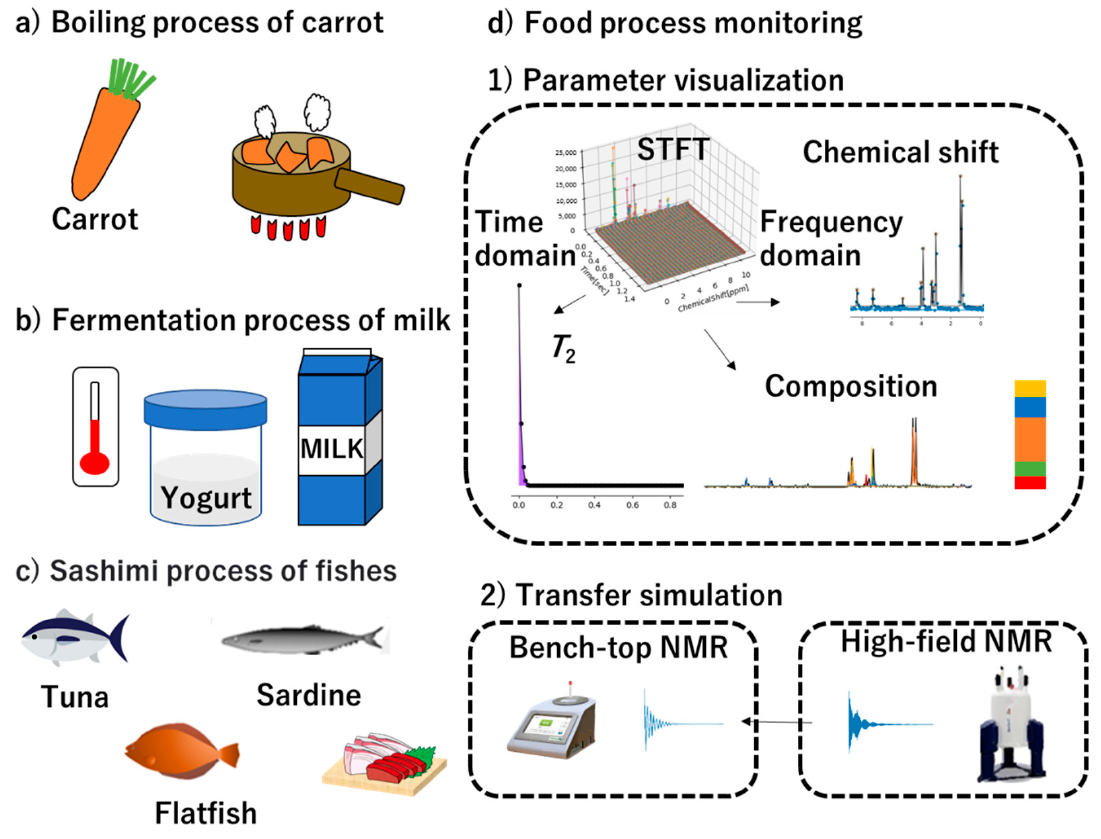
Figure 1. Conceptual diagram of the proposed proton nuclear magnetic resonance ( 1 H-NMR) spectral analysis using parameter visualization of benchtop NMR spectra toward food process monitoring. This study focused on food process monitoring in primary industries such as fishery, dairy farming, and agriculture. For example, food processes of the boiling status of carrot ( a ), the fermentation status of milk ( b ), and the quality of fish meats ( c ) were handled. ( d1 ) For food process monitoring, a parameter visualization of NMR data is depicted. ( d2 ) Conceptual diagram of transition simulation to use high magnetic field NMR data are shown.